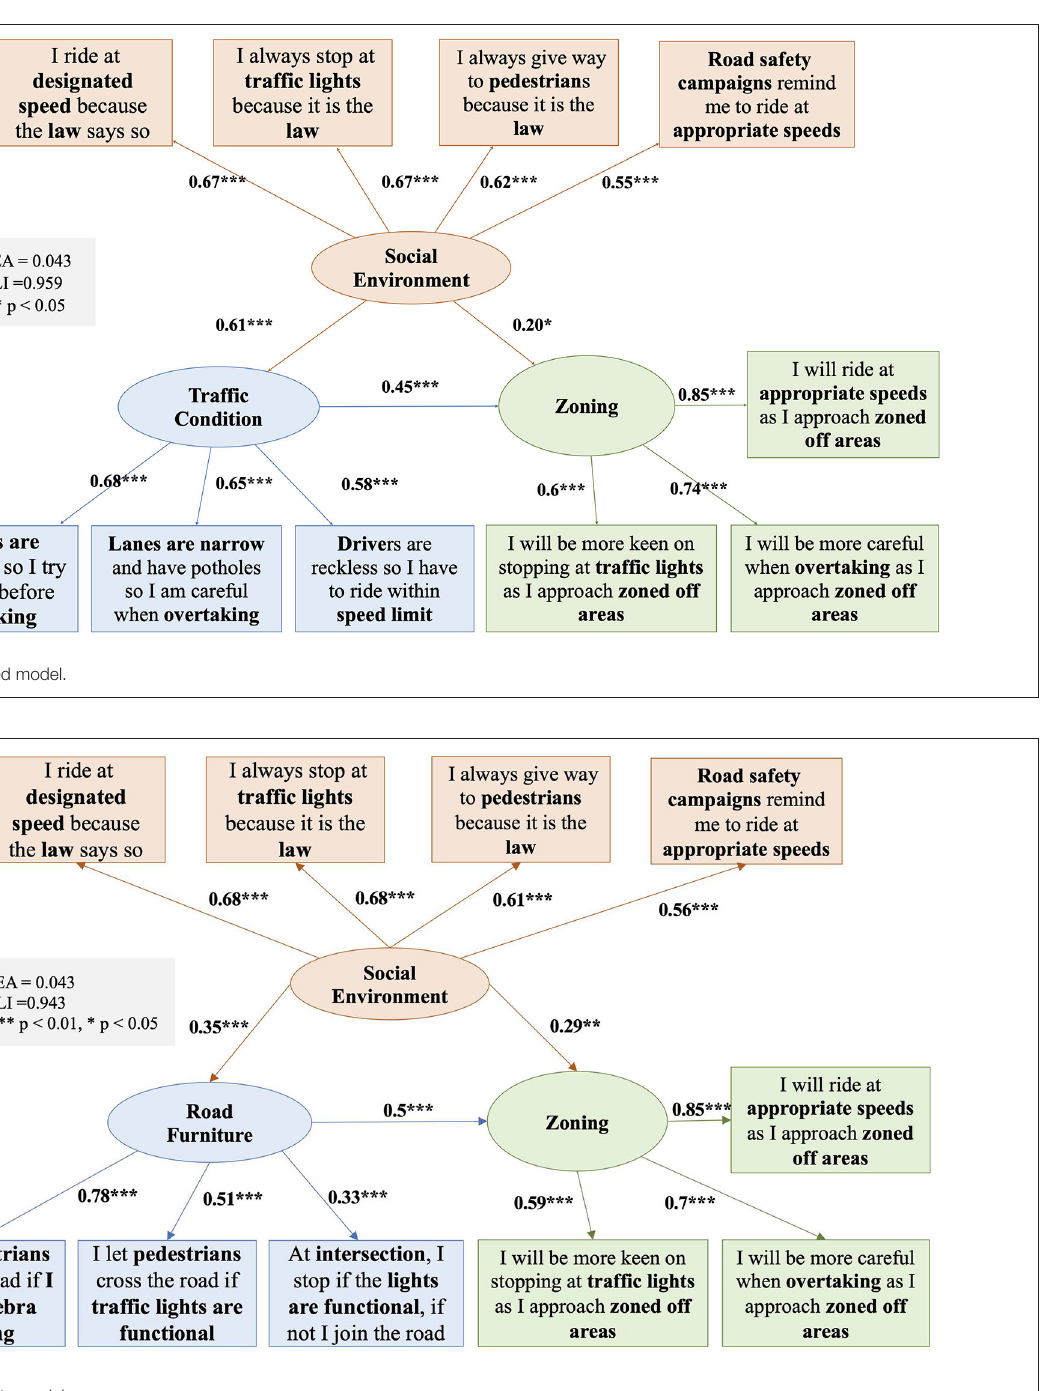
FIGURE 4 | Model 2—Priority